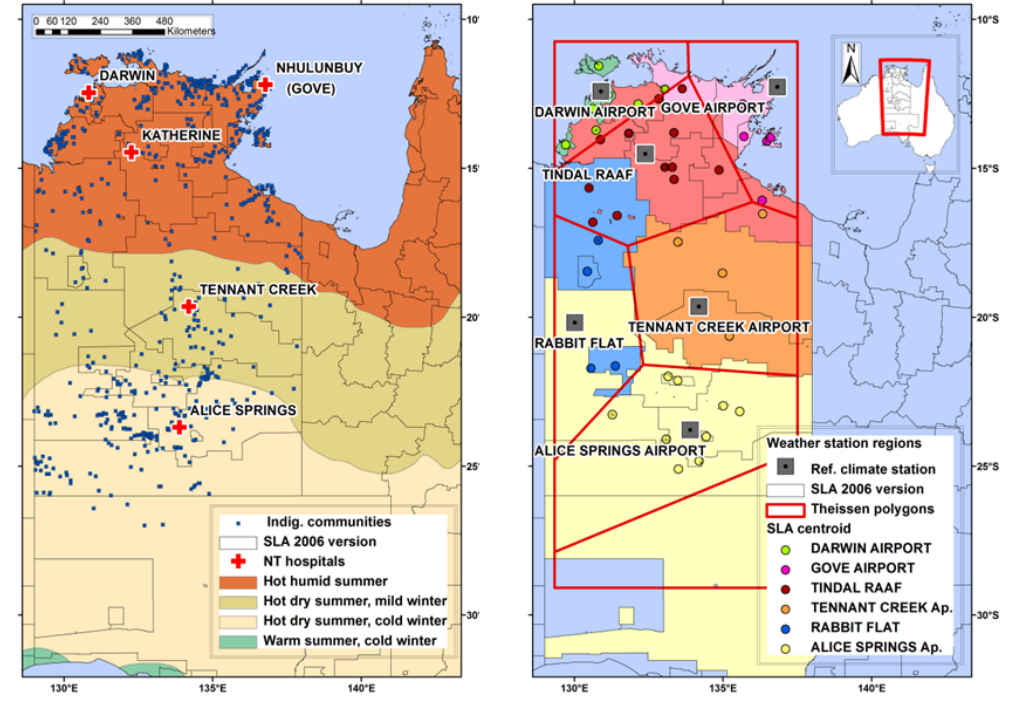
Figure 1. ( Left ) Location of hospitals from which admissions data were accessed denoted by red crosses, and position of Indigenous communities in blue squares overlaying the temperature and humidity zone map of Australia [41] and SLA boundaries (2006) denoted by black lines. ( Right ) Climate reference weather stations denoted by grey squares on which Thiessen polygons denoted by red lines are based. SLA centroids denoted by coloured circles which informed the alignment of each SLA into a polygon